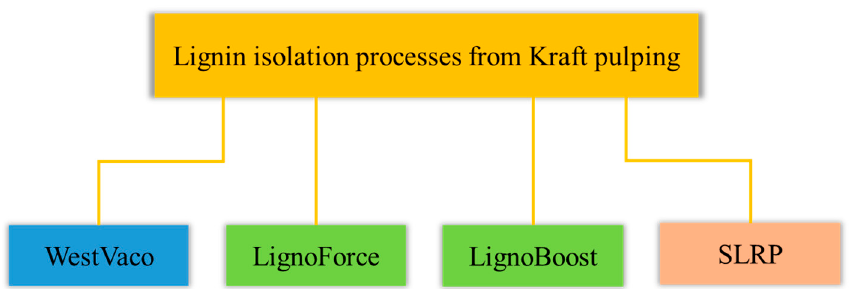
Figure 1. Overview of the lignin isolation processes on industrial and pilot scale.